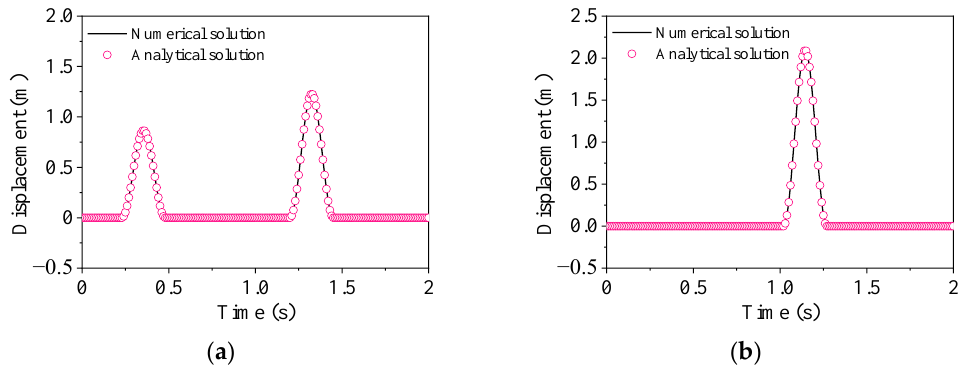
Figure 6. Time history of the displacement of plane SV wave incidence at 30 ° : ( a ) the center point of the bottom; ( b ) the center point of the top.